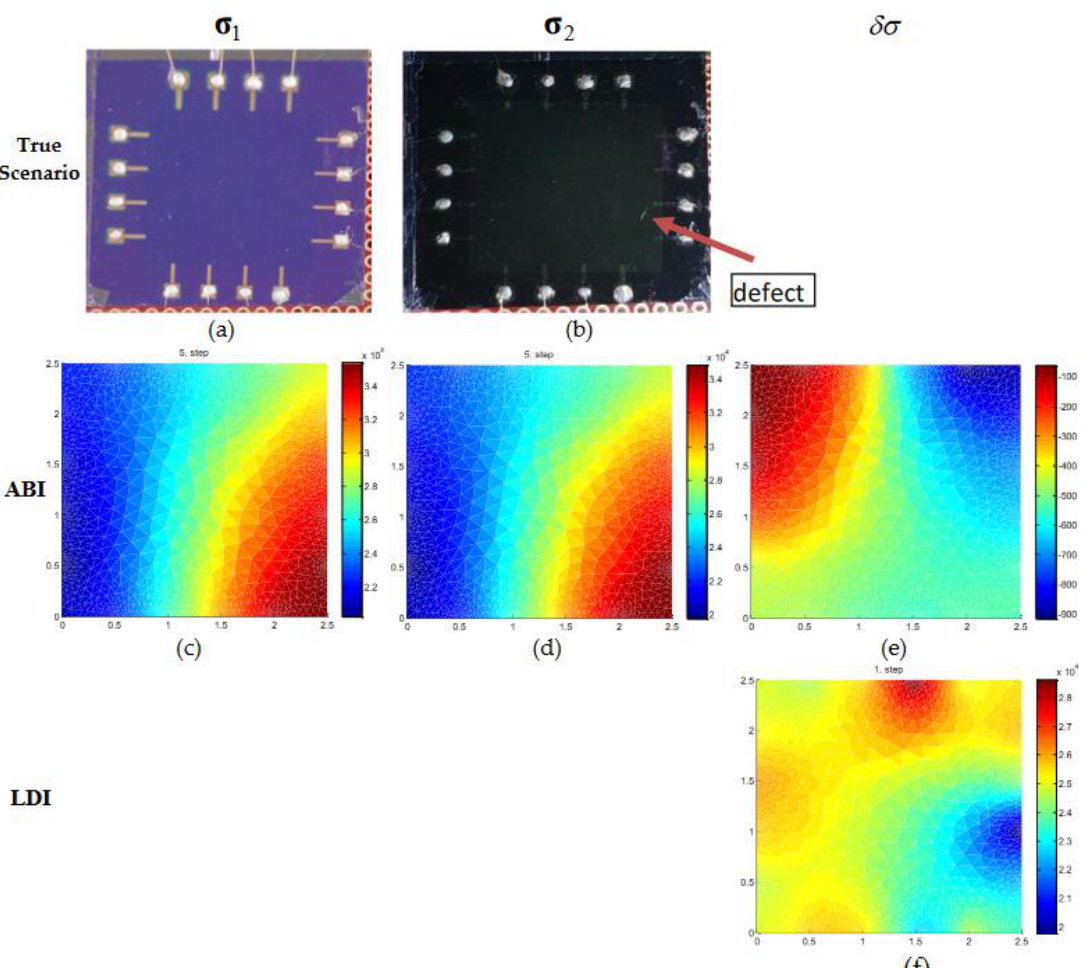
Figure 7. Conductivity estimation of real graphene wafer of size 2.5 × 2.5 cm. ( a , b ) The top row is the true condition of the real graphene sheet without defects and with a single defect used during the experiment. ( c – e ) The second row, ( f ) third row are the estimated conductivities of initial distribution ( σ ) , final distribution ( σ ) , and conductivity change ( δσ ) using ABI and 2 1